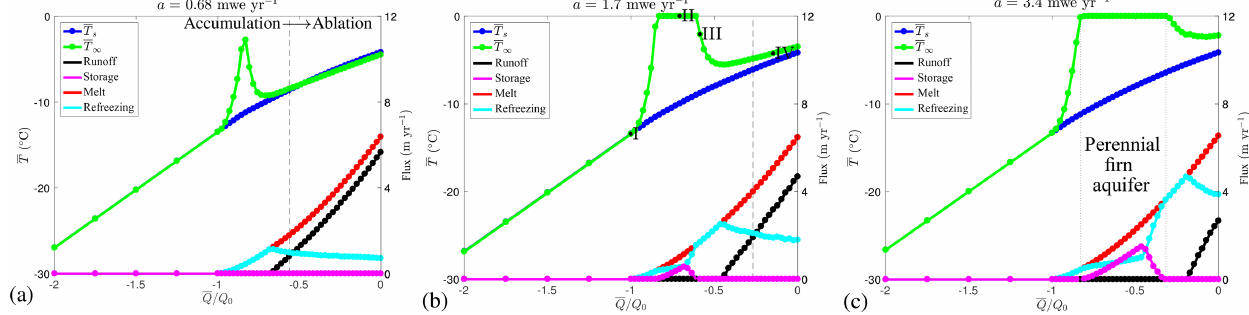
Figure 7. Average meltwater partition (right) and annual mean temperature at the ice surface T s and bottom of the domain T ∞ (left) as a func- tion of the annual mean surface forcing, with accumulation increasing from left to right: (a) a = 0 . 68mw.e.yr − 1 , (b) a = 1 . 7mw.e.yr − 1 , and (c) a = 3 . 4mw.e.yr − 1 . For Q > − Q 0 melting occurs at the surface and meltwater percolation warms the bottom of the domain. Dashed lines in panels (a, b) mark the transition from an accumulation to ablation zone and the roman numerals in panel (b) correspond to the solutions in Fig.